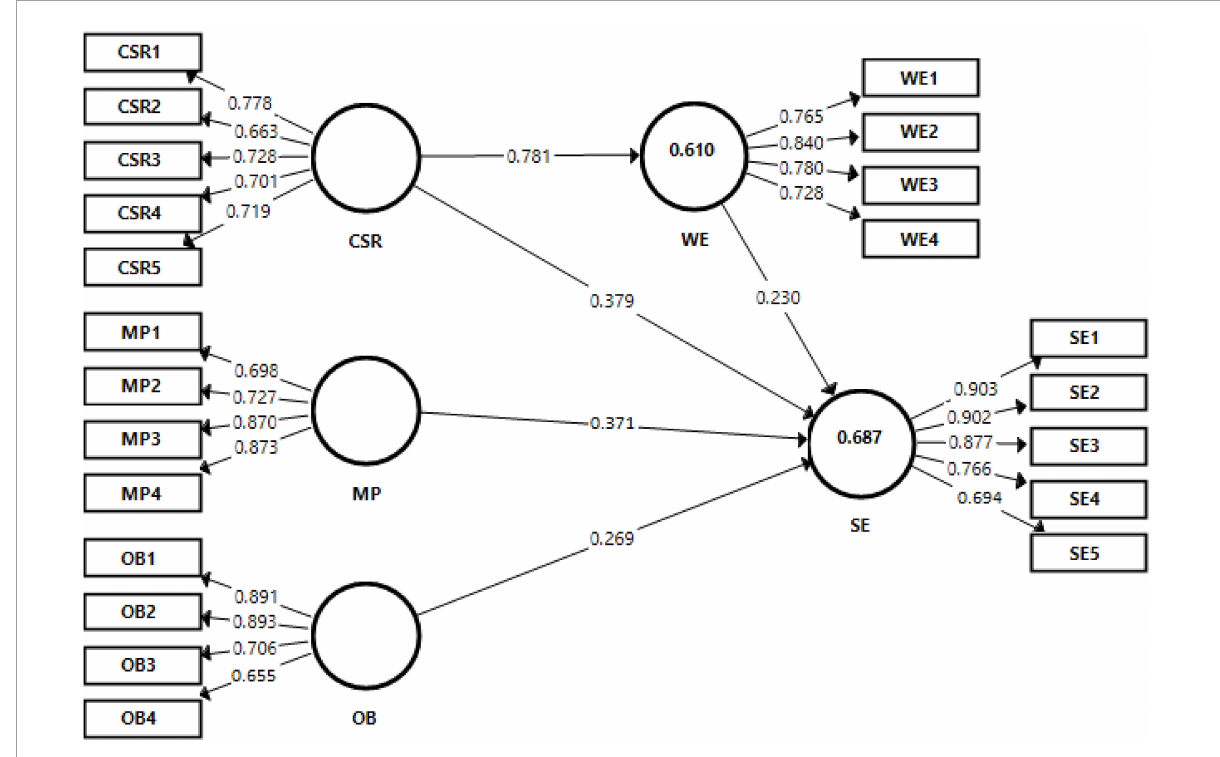
FIGURE2 The measurement